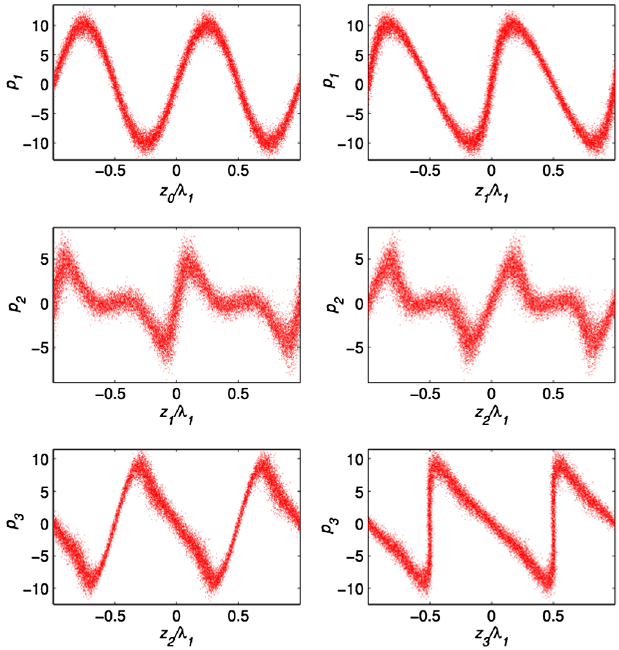
FIG. 5. Synthetic sawtooth wave generation with three modu- lations of wavelength (cid:6) 1 . Here A 1 ¼ 10 , A 2 ¼ 3 A 1 = 4 , A 3 ¼ A 1 , B 1 ¼ (cid:1) 1 = 2 A 1 , B 2 ¼ (cid:1) 2 B 1 , B 3 ¼ 2 B 1 , (cid:3) 2 ¼ (cid:3) 3 ¼ (cid:1) in Fig. 2. The direction of the sawtooth is reversed by changing the sign of the dispersion in each stage. Finally, a more complex single-frequency manipulation also generates a synthetic square wave distribution (Fig. 6).